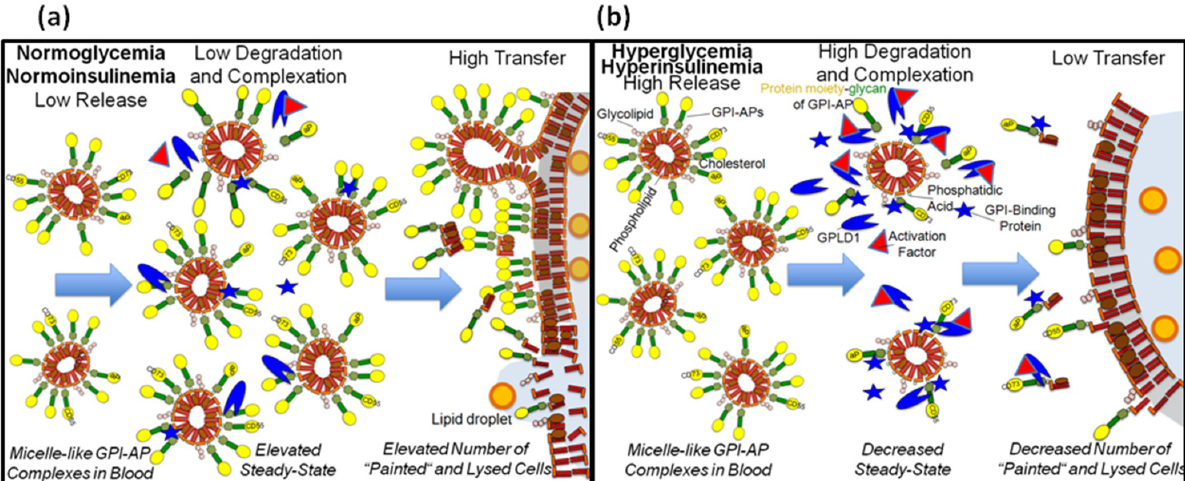
Figure 12. Model for the path of full-length GPI-APs in micelle-like complexes in mammalian blood. ( a ) Full-length GPI-APs from the surface of relevant donor blood/tissue cells, such as adipocytes, are released into micelle-like complexes in the blood in the normoglycemic normoinsulinemic state at low rate. This is paralleled by the degradation of the GPI-APs through lipolytic cleavage of their GPI anchor by GPLD1 at a low rate, leading to accumulation of the complexes with time. The resulting steady-state concentration of full-length GPI-APs in micelle-like complexes is faced with a considerably low amount of GPI-interacting proteins, among them GPLD1, which associate with the GPI anchor via the glycan core. Together, these conditions enable the efficient translocation of full-length GPI-APs from the micelle-like complexes or fragments generated thereof into the outer leaflet of plasma membranes of relevant acceptor blood/tissue cells, such as adipocytes. Overall, this intercellular transfer leads to considerable increase in the number of “painted” cells, i.e., cells expressing exogenous GPI-APs at their surface. Eventually, as a consequence of excessive transfer, the “painted” cells may undergo lysis in the course of disintegration of their plasma membranes by the translocated amphiphilic full-length GPI-APs. ( b ) The upregulated release of full-length GPI-APs into micelle-like complexes in the blood in the hyperglycemic hyperinsulinemic state becomes counteracted by their degradation through GPLD1 at an elevated rate. The resulting steady-state concentration of full-length GPI-APs in the micelle-like complexes is lower compared to that of the normoglycemic normoinsulinemic state. This, in combination with efficient interaction of the full-length GPI-APs with GPI-interacting proteins, prevents their translocation to the surface of acceptor blood/tissue cells, leading to their diminished “painting” and “lysis” and impaired intercellular transfer of GPI-APs.